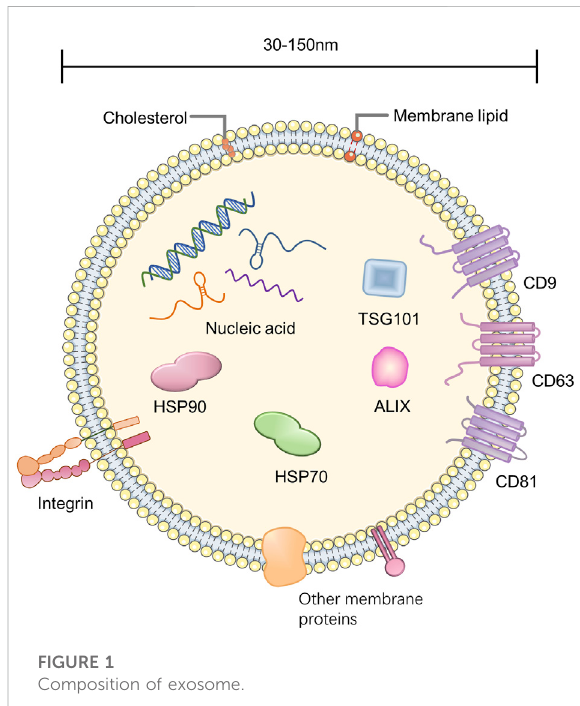
FIGURE 1 Composition of